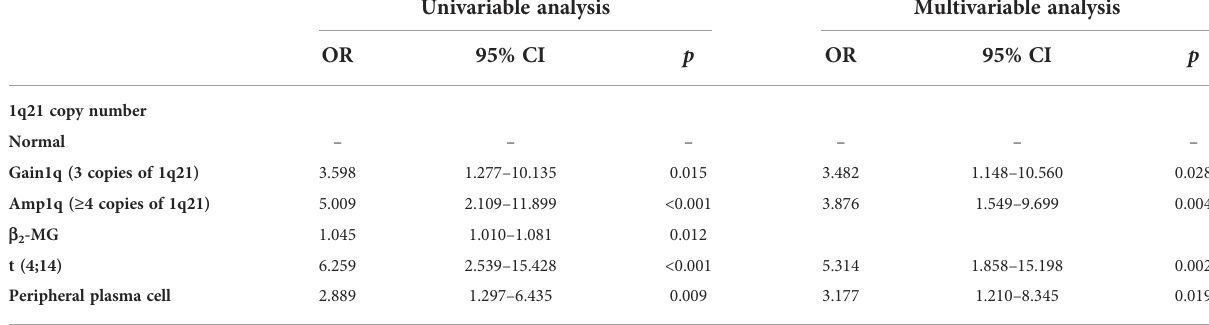
TABLE 2 Univariable and multivariable logistic regression of survival